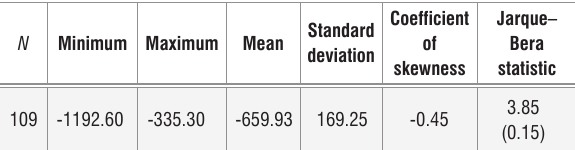
Coefficient Standard of deviation